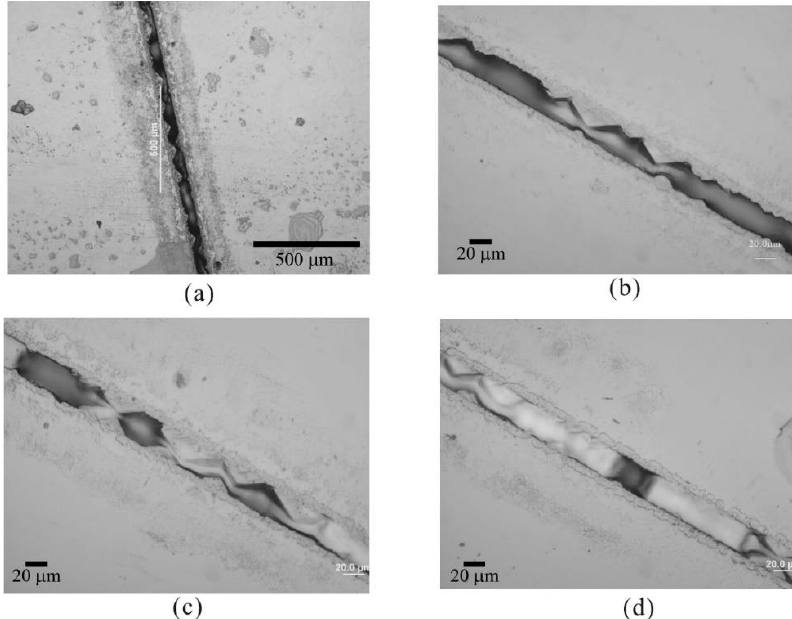
Figure 6. ( a – d ) Optical microscope images of consecutive stages of liquid phase epitaxy growth (up to 10 min) inside V grooves on lithium niobate substrates.